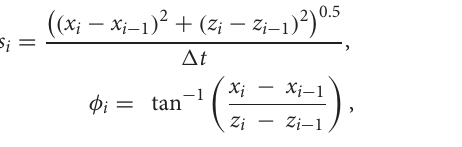
possible starting positions in a square configuration, with initial interpersonal spacing of 0.5, 1.0, 1.5, or 2.5 m on a